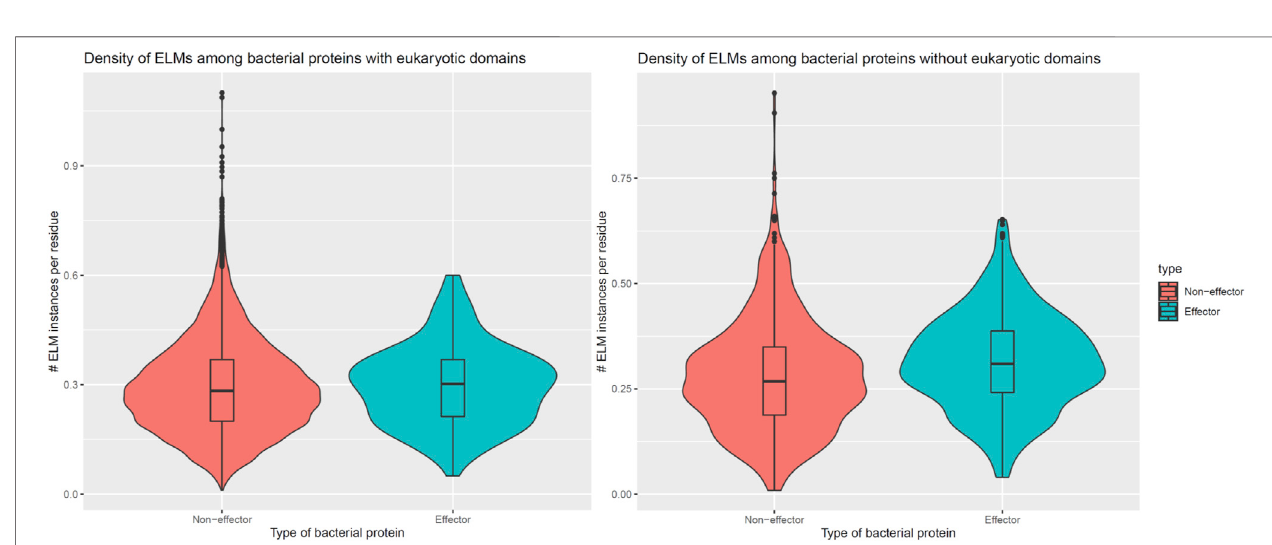
FIGURE 6 | In the absence of eukaryotic-like domains or domains in general, effectors contain a higher density of eukaryotic linear motifs compared to non- effectors. Left: In the presence of eukaryotic-like domains, effectors encode 0.30 ELM instances per disordered residue, a slightly higher density that is not statistically signi fi cant(Wilcoxon test,two-tailed p (cid:2) 0.3) compared to0.28ELMinstancesper disorderedresidueinnon-effectors. Right: Intheabsenceofeukaryotic-likedomains or among proteins without Pfam domains, effectors encode 0.31 ELM instances per disordered residue, a higher density that is statistically signi fi cant